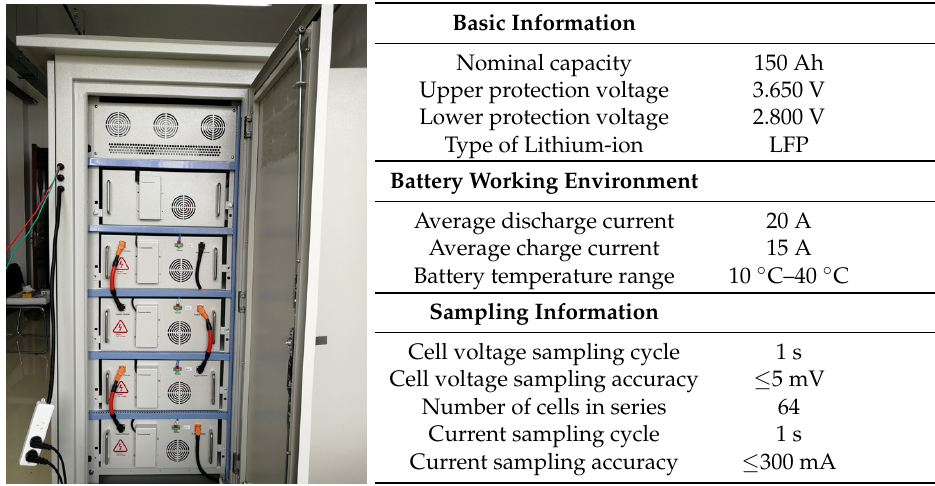
Figure 7. Basic information of LFP batteries on an experimental